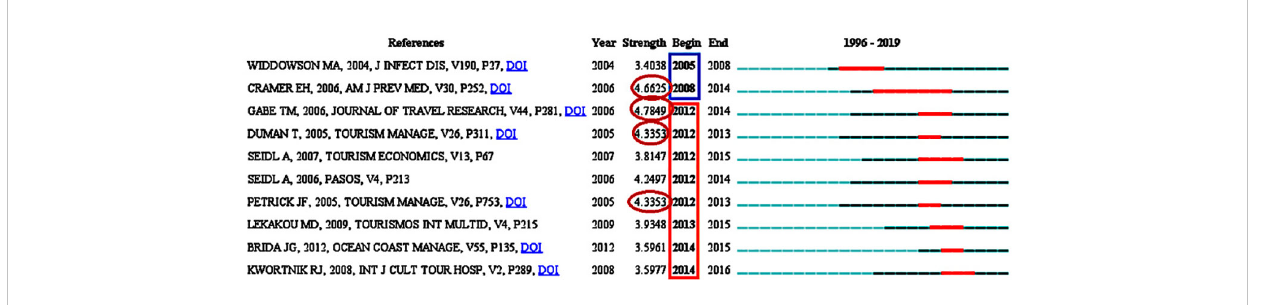
FIGURE 6 The ten most cited references in cruise research. The blue indicates the time interval, the red indicates the time period when the document is